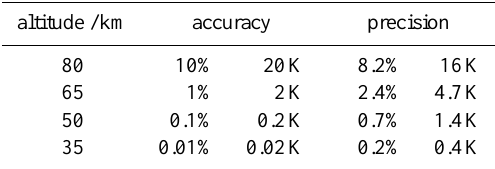
Table 7. Accuracy and precision of a typical lidar temperature pro- file with 2-h integration time, taken during darkness conditions on a clear weather winter